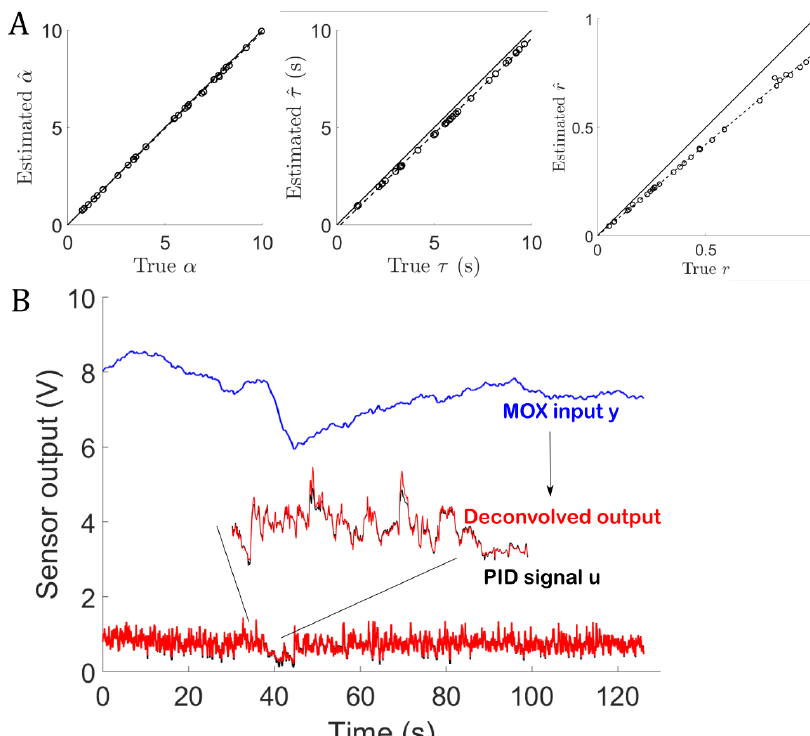
Figure 6. Supervised identification / deconvolution with a simulated MOX sensor. A Least-squares identification using Equations (13) and (14) ( n = 30 trials). For each trial, the model parameters τ , r , α are randomly generated within (0,10 s), (0,1) and (0,10), respectively. B Deconvolution of the MOX output in the worst-case scenario: τ = 10 s , r = 1, α = 10 (maximum estimation bias in A).